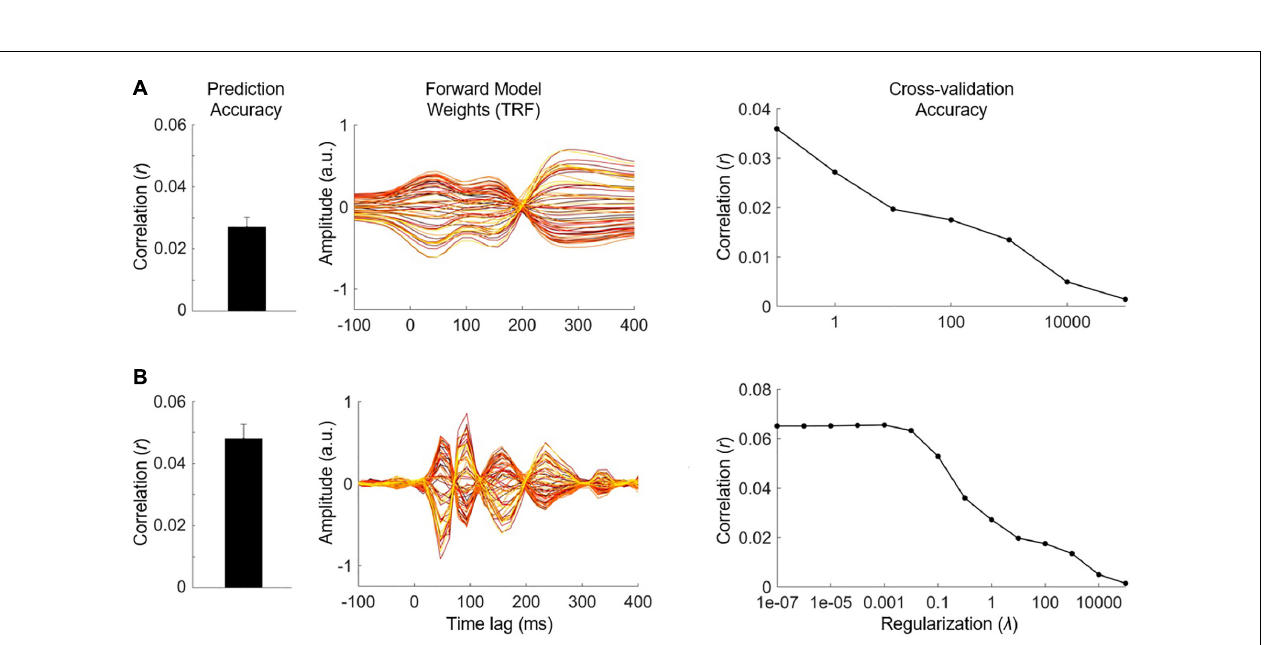
Frontiers in Neuroscience |